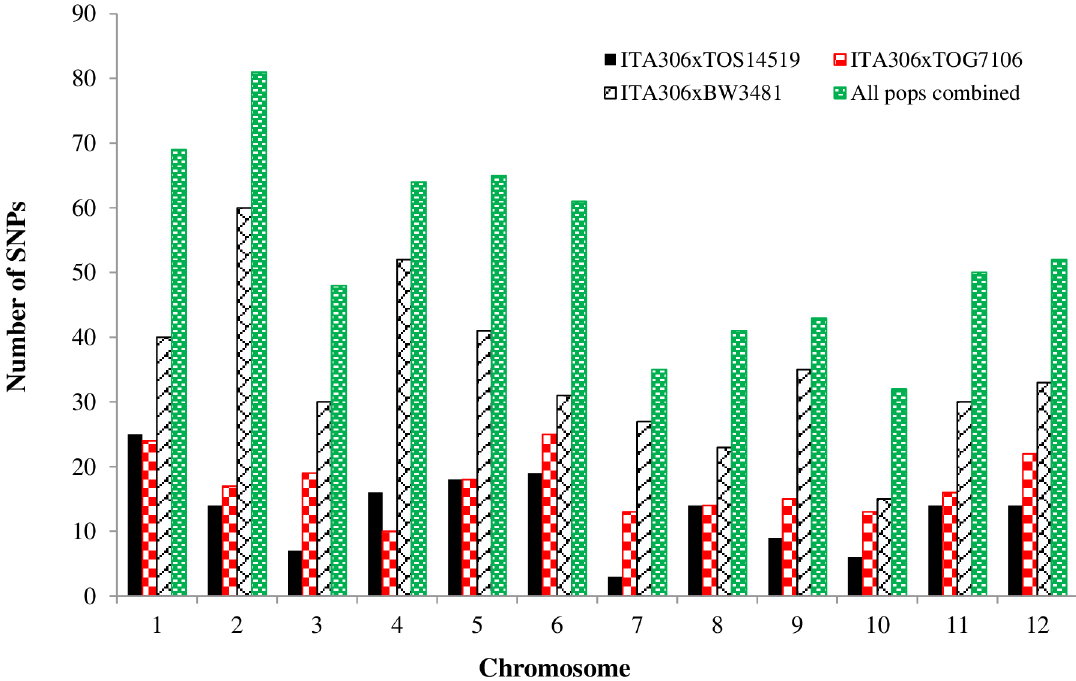
Fig 1. Summary of the number of SNPs used for QTL mapping for each of the three populations and combined across all populations.